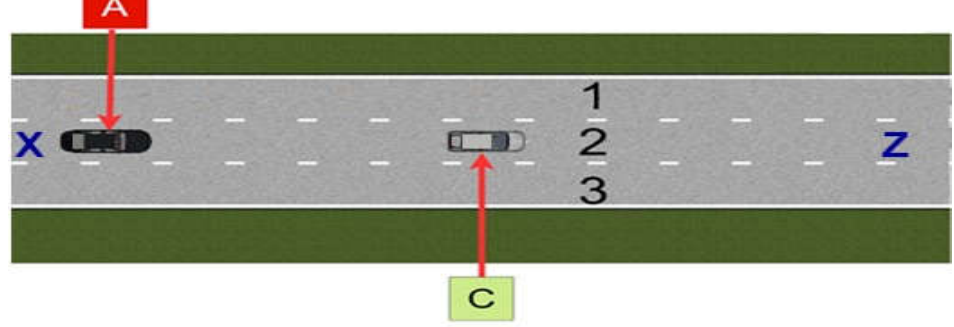
Figure 3. OMS with vehicles located in the center lane (2).